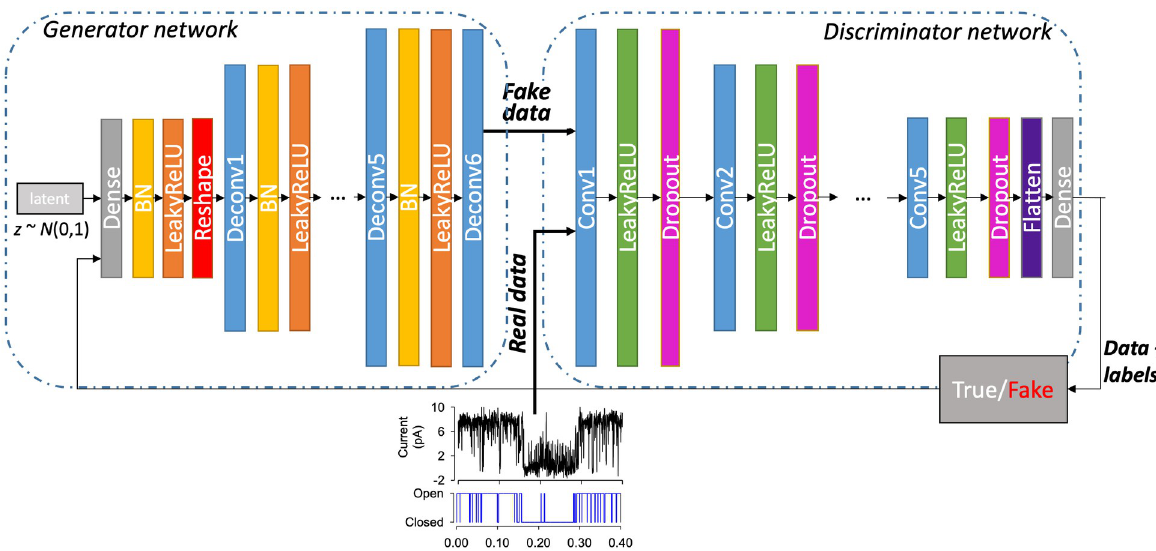
Fig 2. DeepGANnel network architecture. On the left is a generator network of DeepGANnel in which the input is a random noise and output is a 2D image by 2x1280 that is converted from 1-D time series. The generator model in this architecture uses three deconvolution layers (upsampling) to produce an image from seed (random noise shape by 2x1280). Several Dense layers are used to take the noise input and transform into a desired image by up-sampling (Deconv or transposed convolutional layer) steps size of 2x1280. At each layer, Leaky Rectified Linear Unit (LeakyReLU) is used as activation function with batch normalisation, except output layer which uses tanh activation function. The discriminator model comprises of several convolutional layers with the same activation function (LeakyReLU) at each layer to classify whether an image is real or fake by comparing the sampled data to real data. Dropout layers were also appended to all convolutional layers except input layer with the value of 0.3 to reduce overfitting. Finally, a Dense output layer is used after flattening the network structure with classified labels.